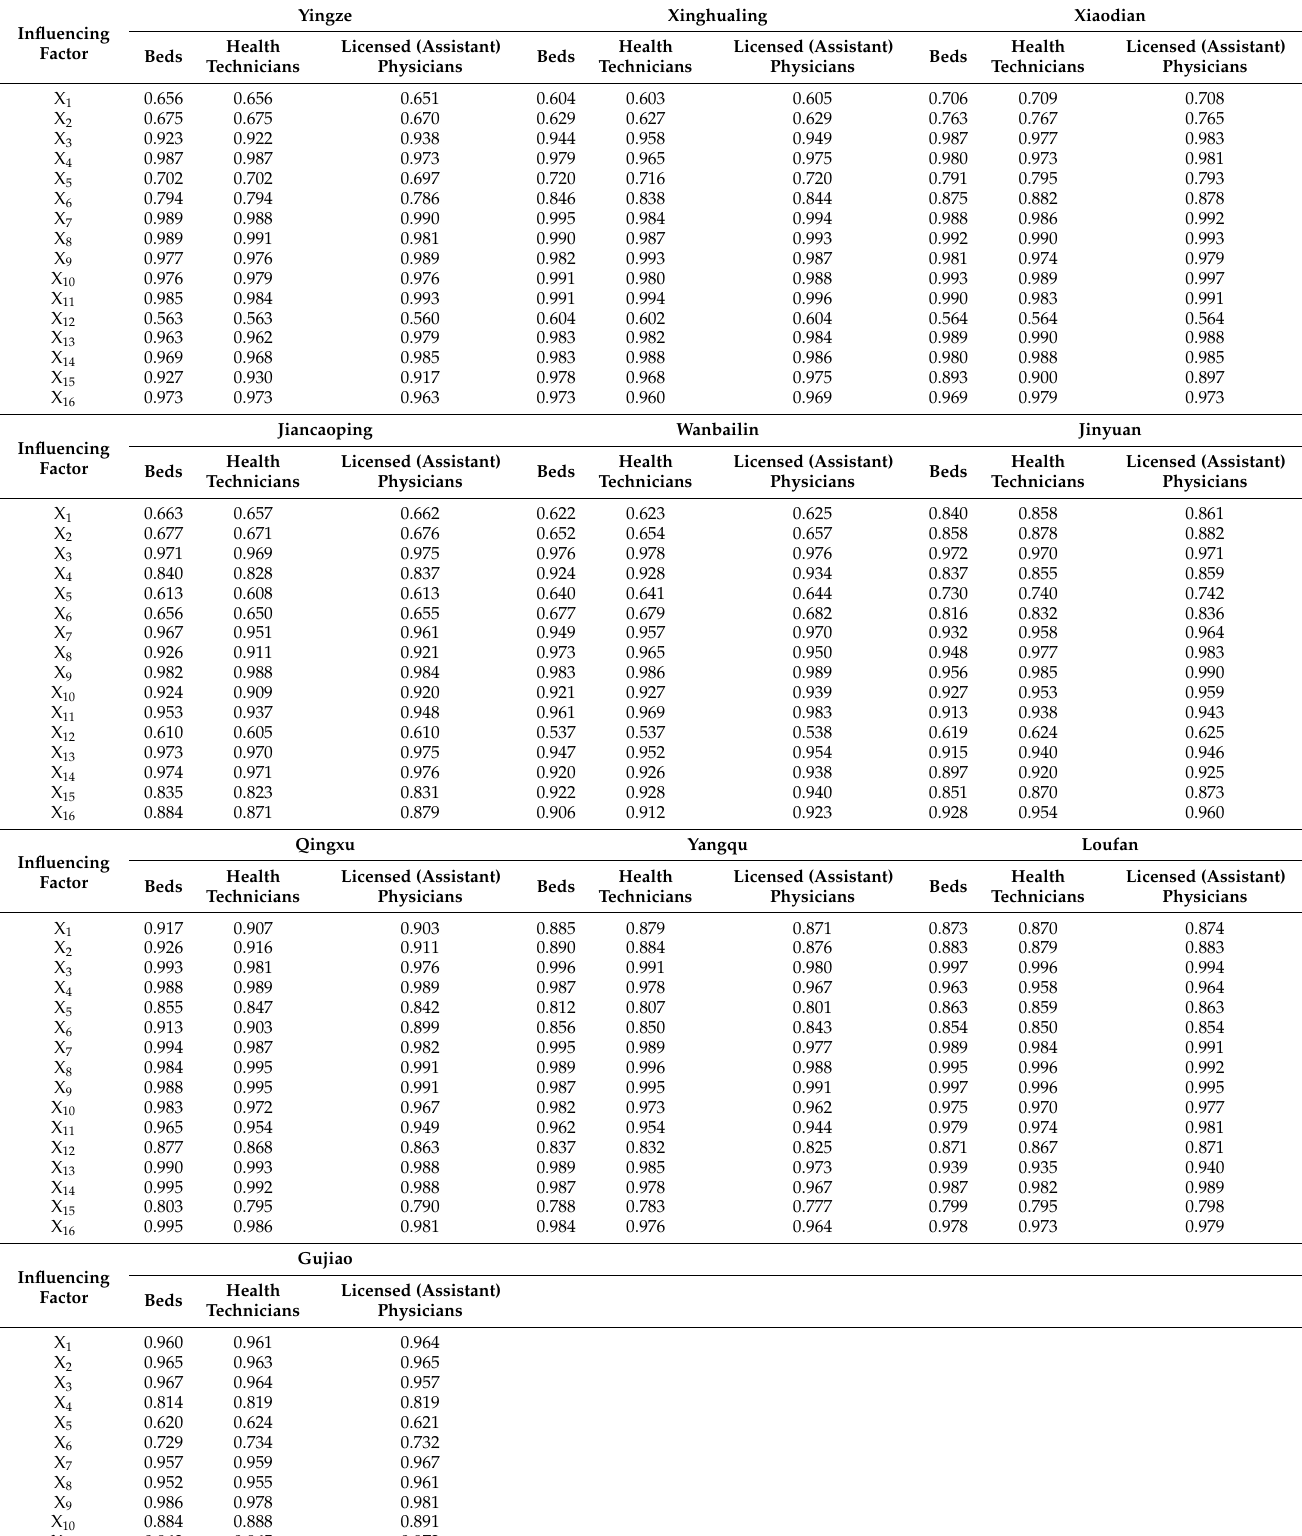
Table A2. Value of influencing factors of medical and health resources allocation in